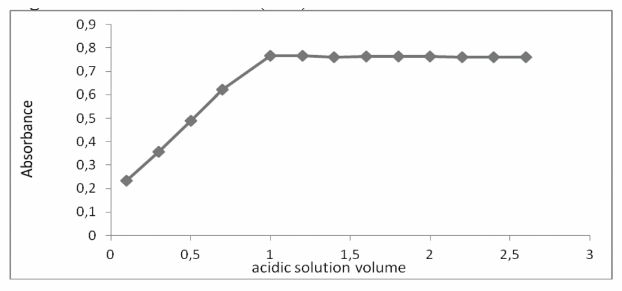
Figure 6 - Volume of HCl ( ml ) effect on the absorbance of color product